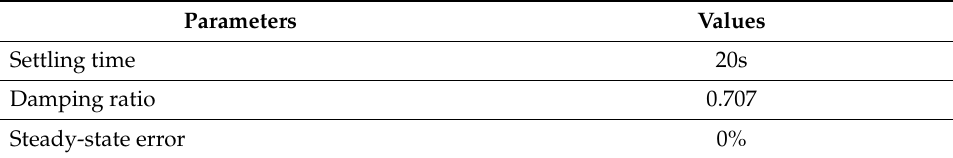
Table 5. X3D Quadrotor reference model